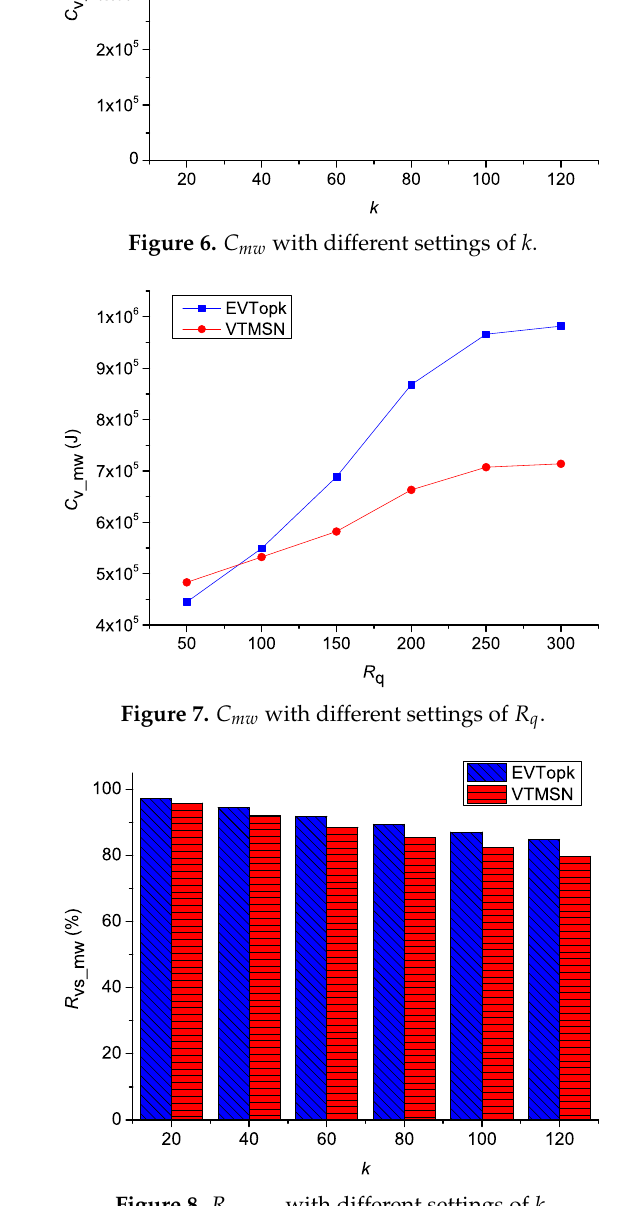
Figure 8. R vs _ mw with different settings of k